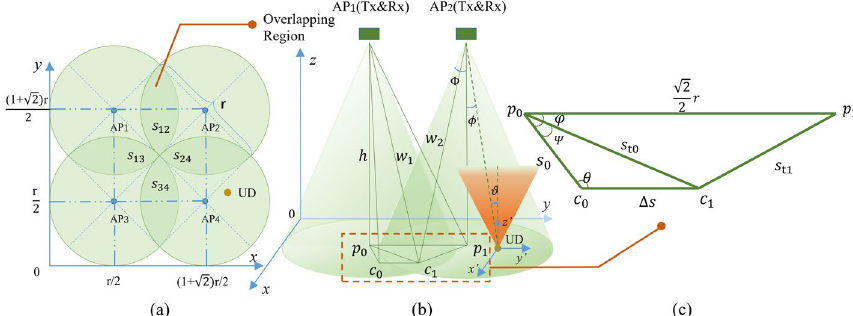
Fig. 2 Relevant diagram of system model: a A distribution mode of APs, b an AM model and c a geometry diagram of the AM model projected on the ground. Figure is illustrated in “System model” section. a shows a top view of four access points coverage and their geometric annotations. b depicts the access model in bidirectional visible light communications system, the light green and orange part illustrate the coverage of visible light signal from access point in downlink and from user’ terminal in uplink, respectively. c illustrates the geometric structure projected on the ground from